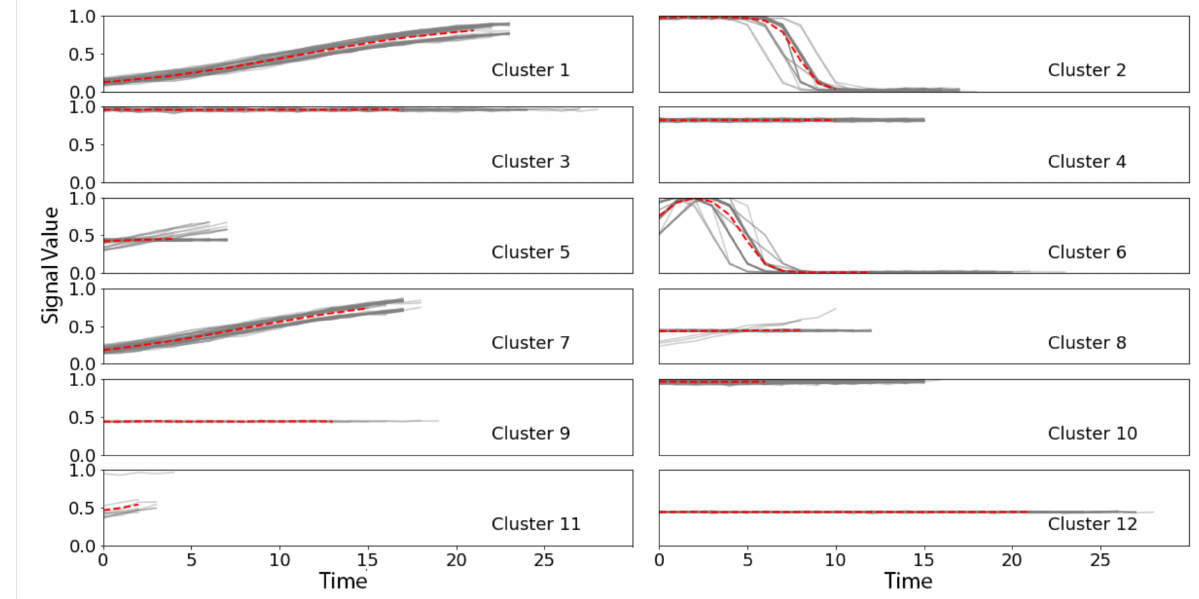
Figure 6. Final set of 12 shapelets for W-TSS in the TRACE dataset, identified as the center lines (red) from global alignment kernel k-means clustering results on the W-TSS candidate shapelets, with time series members (grey solid line) and centerlines (red dash line). X-axis: time, Y-axis: risk of instrumentation failures.